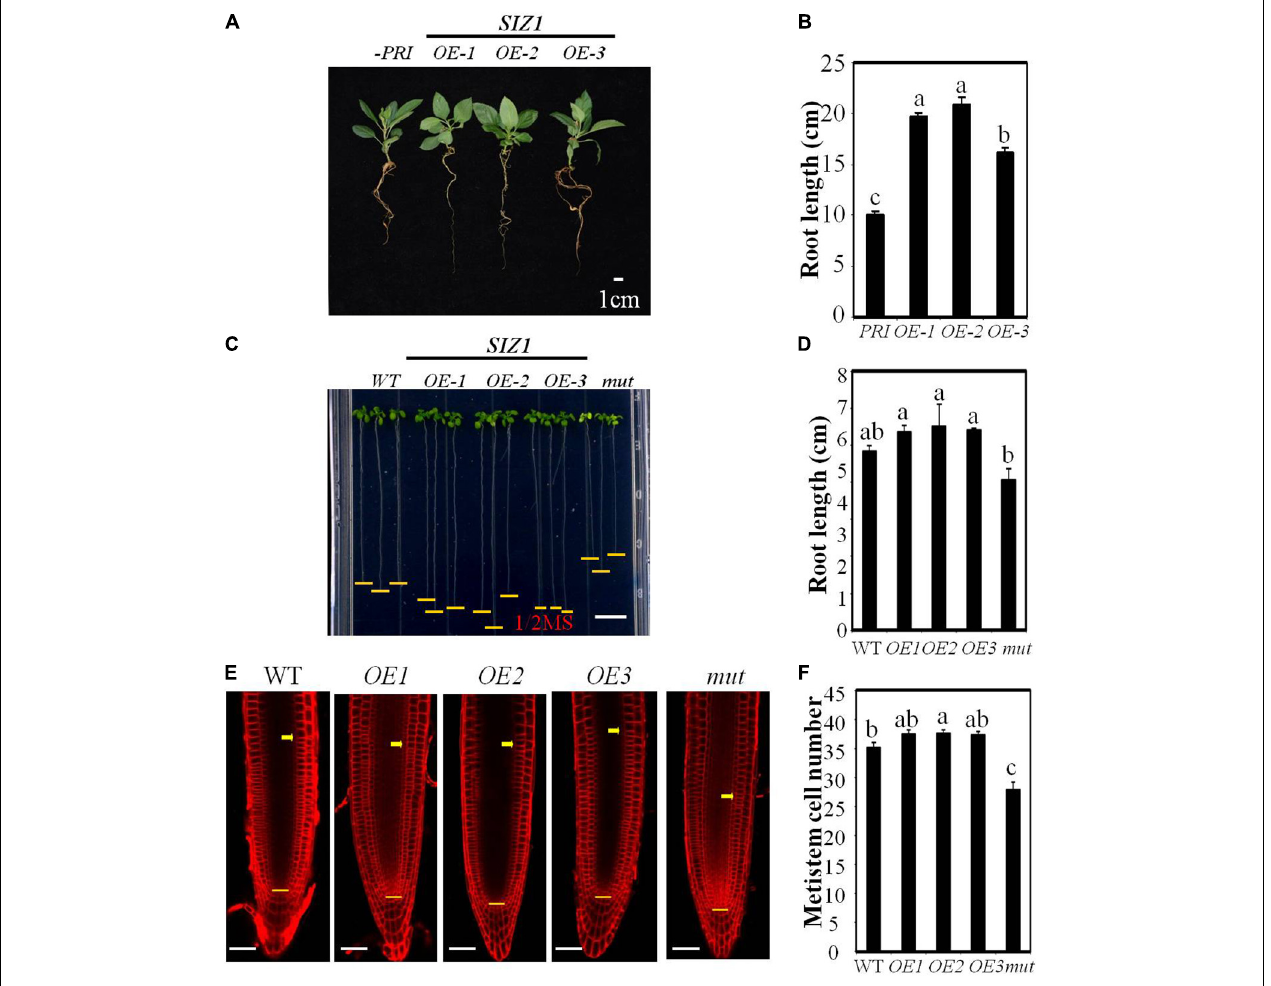
FIGURE 6 | MdSIZ1 positively regulates cell proliferation in the root meristematic zone and root growth. (A) Phenotype of 40-day-old apple seedlings of MdSIZ1 overexpression lines (OE-1, OE-2, OE-3) and the control line infected with empty vector. Bars = 1 cm. (B) Primary root length of 40-day-old apple seedlings in (A) . (C) Root phenotype of 7-day-old Arabidopsis seedlings of the WT, MdSIZ1 overexpression (OE-1, OE-2, OE-3) and atsiz1 mutant ( mut ). Bars = 1 cm. (D) Primary root length of the WT, OE-1, OE-2, OE-3, and mutant Arabidopsis seedlings in (C) . (E) Confocal microscopy images of the FM4-64-stained WT, MdSIZ1 overexpression lines (OE-1, OE-2, OE-3) and atsiz1 mutant ( mut ) Arabidopsis seedlings. Yellow arrows and horizontal lines indicate the approximate position of root meristem zone. Bars = 50 µ m. (F) Meristem cell number of the WT, OE-1, OE-2, OE-3, and mutant Arabidopsis seedlings. The cell number of 7-day-old roots was counted and shown as averages ± SD ( n = 5 to 10). Data in B,D,F are the means ( n = 5 to 20) ± SD. Different letters on each bar denote significant differences ( p < 0.01, ANOVA, Tukey’s